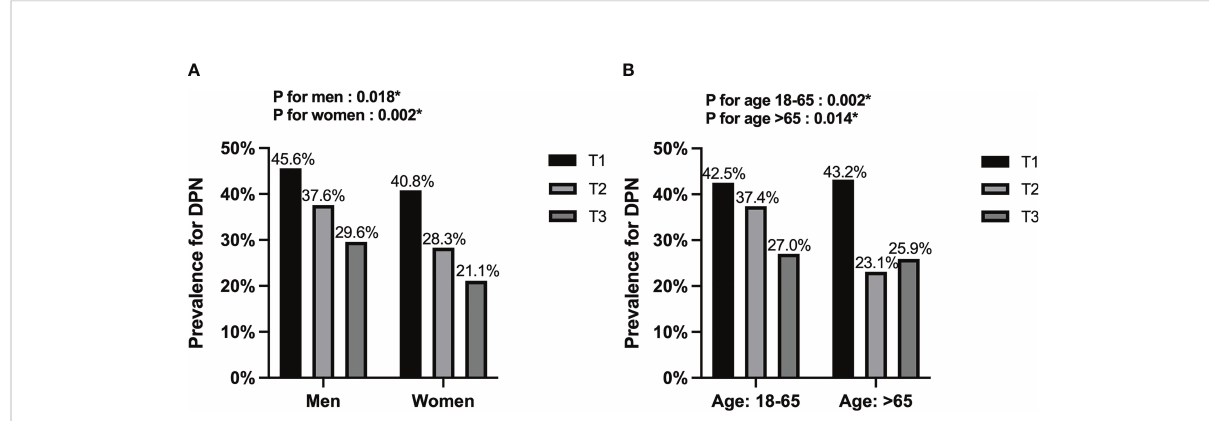
FIGURE 1 Strati fi cation analysis of DPN among the fT3 tertiles. (A) Strati fi ed by sex; (B) Strati fi ed by age. DPN, diabetic peripheral neuropathy.